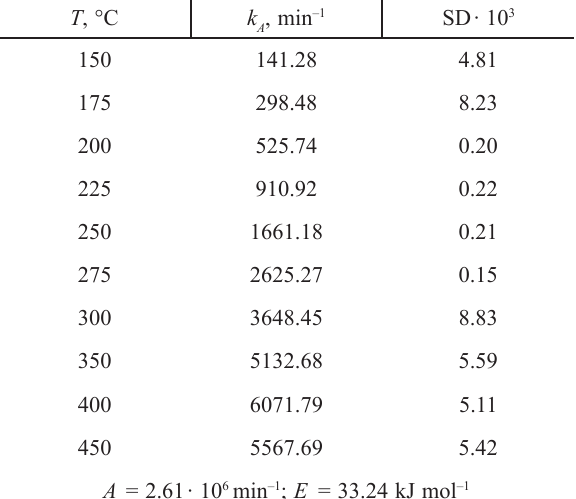
M. Duplančić et al., Catalytic Oxidation of Toluene on Hydrothermally Prepared…, Chem. Biochem. Eng. Q. , 31 (4) 375–383 (2017) Table 1 – Estimated values of the rate constants, k mean square deviations, sD, between the experimentally ob- tained and theoretically predicted values T ,